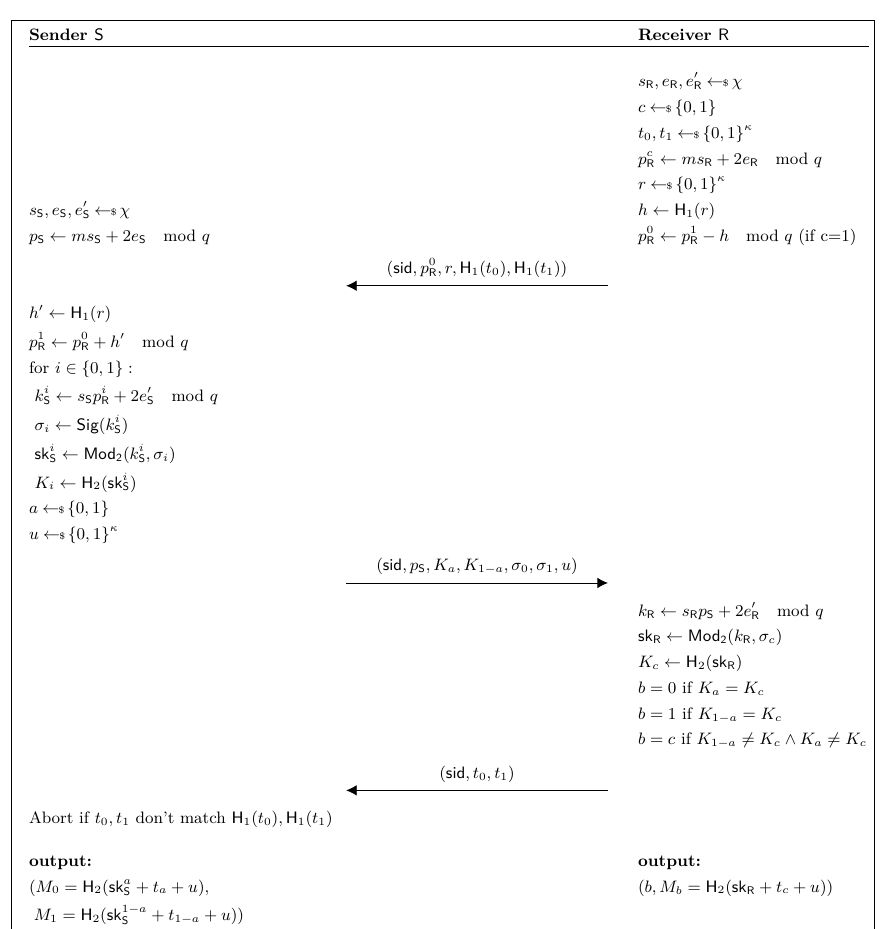
Figure 1: 3-round ROT protocol based on the RLWE